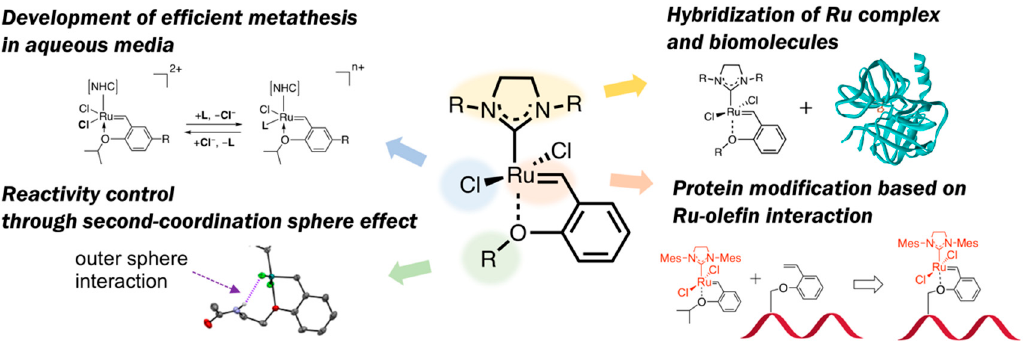
Figure 2. Outline of this review article: Structural modification of HG-II-type complexes for various demands.